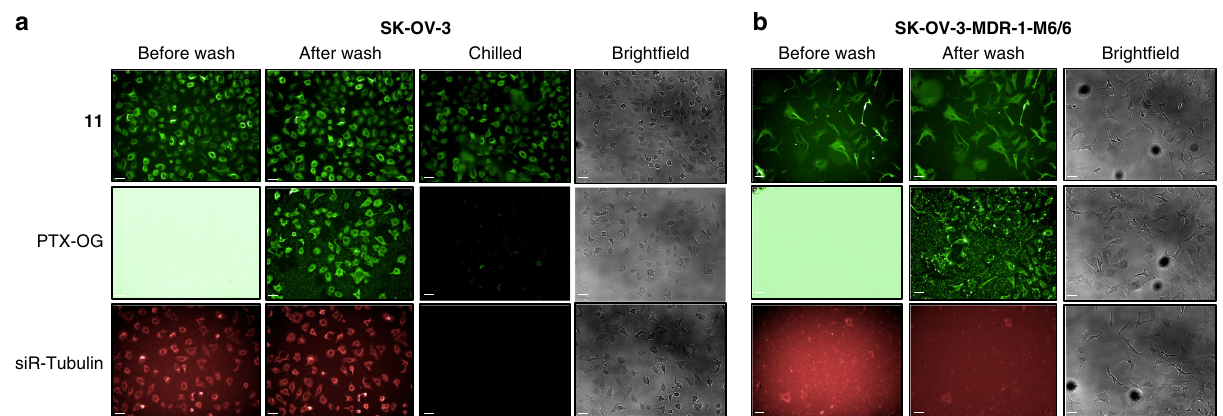
Fig. 8 Taccalonolide probes compared to commercial taxane-based probes. a SK-OV-3 human ovarian cancer cells were treated with 0.5 µ M of 11 , Tubulin Tracker Green (PTX-OG; Thermo Fisher; middle), or siR-Tubulin (Cytoskeleton, Inc; bottom) for 5 h and imaged before treated media was removed (before wash), after the treated media were replaced by fresh medium (after wash), or after the treated cells were chilled at − 20 °C for 20 min and fi xed (chilled). b SK-OV-3-MDR1-M6/6 human ovarian cancer cells expressing P-glycoprotein were treated with 0.5 µ M of each probe for 5 h and imaged at 37 °C before and after washing. The same image acquisition and visualization conditions were used for all images obtained for each probe. Bright fi eld images are shown in the far right column for each fi gure. Scale bars = 50 µ m for all images. Source data are provided as a Source Data fi